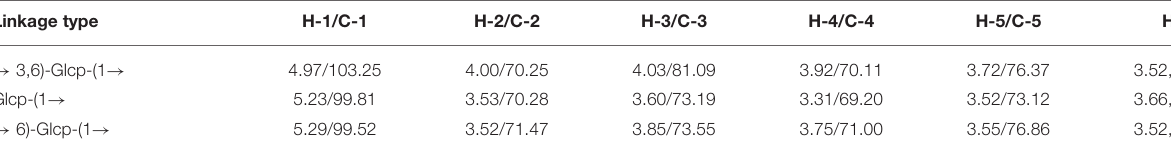
TABLE 2 | 1 H and 13 C NMR chemical shifts of polysaccharide MDP in D 2 O.